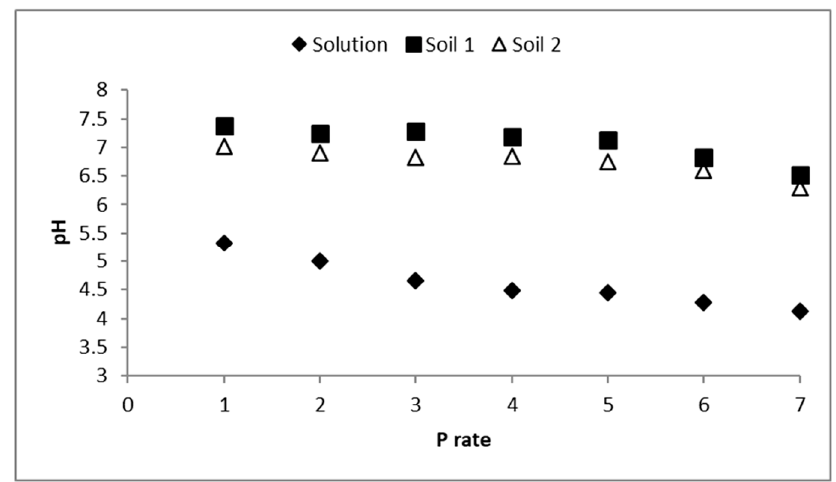
Figure 3. Mean pH values in the initial and in the equilibrium solutions for the two soils. P rates (mg/L), 1: 2.36, 2: 6.77, 3: 11.08, 4: 15.92, 5: 21.96, 6: 40.59, 7: 88.88.